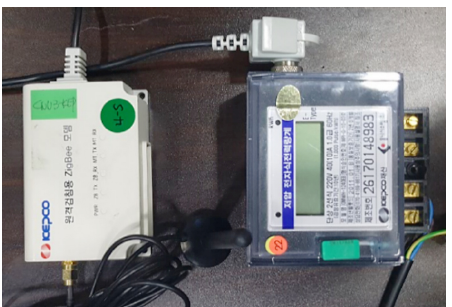
Figure 11. ZigBee modem for smart meters (CNU Global Co.